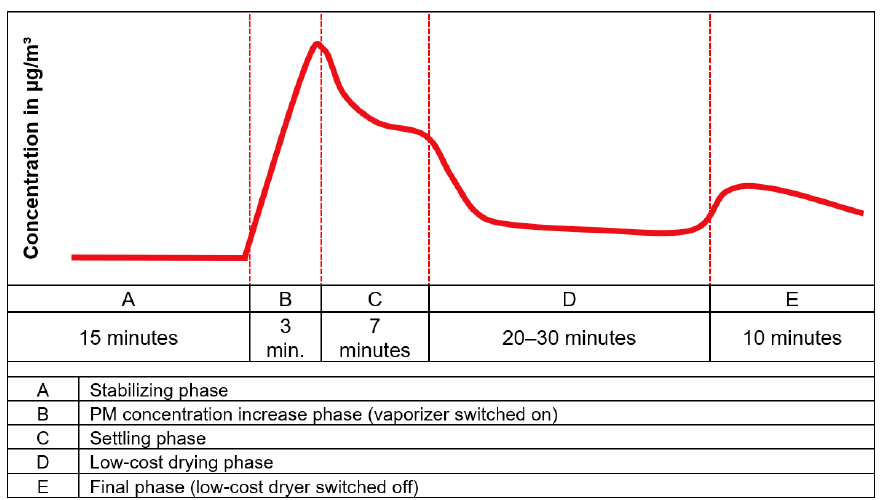
Figure 6. Temporal variation of an ideal PM concentration curve during a standard experiment.